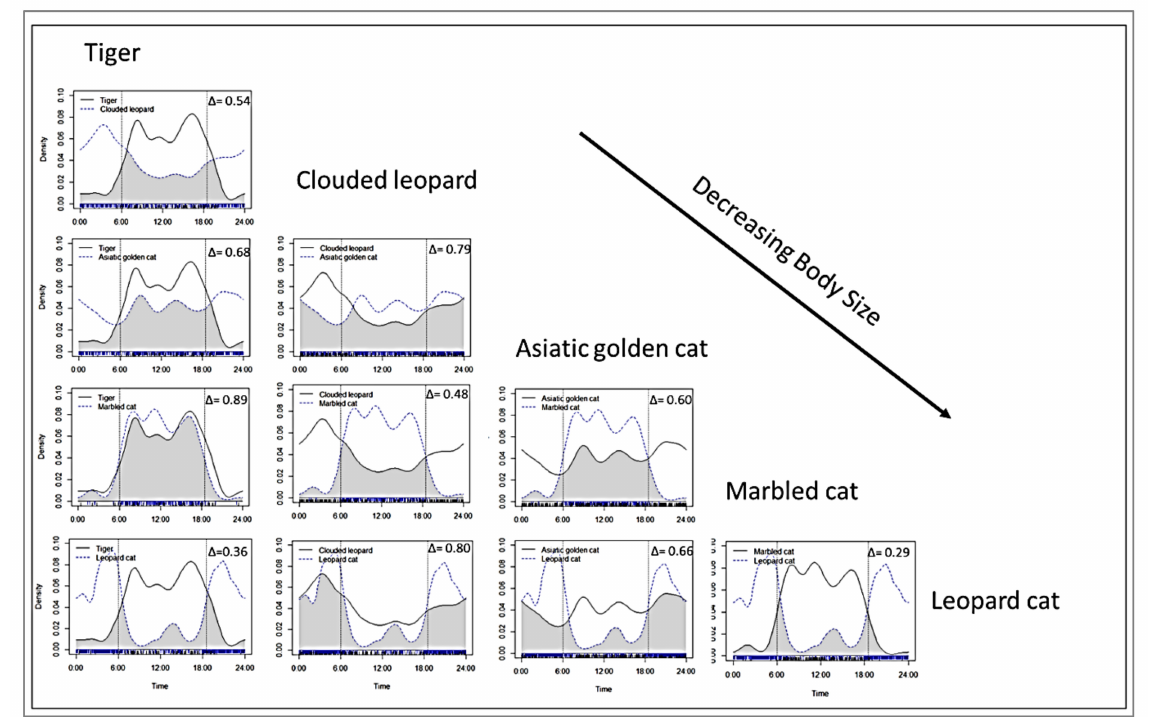
Figure 5. Activity overlap of the tiger, clouded leopard, marbled cat, and Asiatic golden cat from all camera trap stations ( n = 1344). Dotted vertical lines at 06:00 and 18:00 represent the approximate dawn and dusk. Activities detected for each species are represented by blue and black coloured rugs on the x-axes.